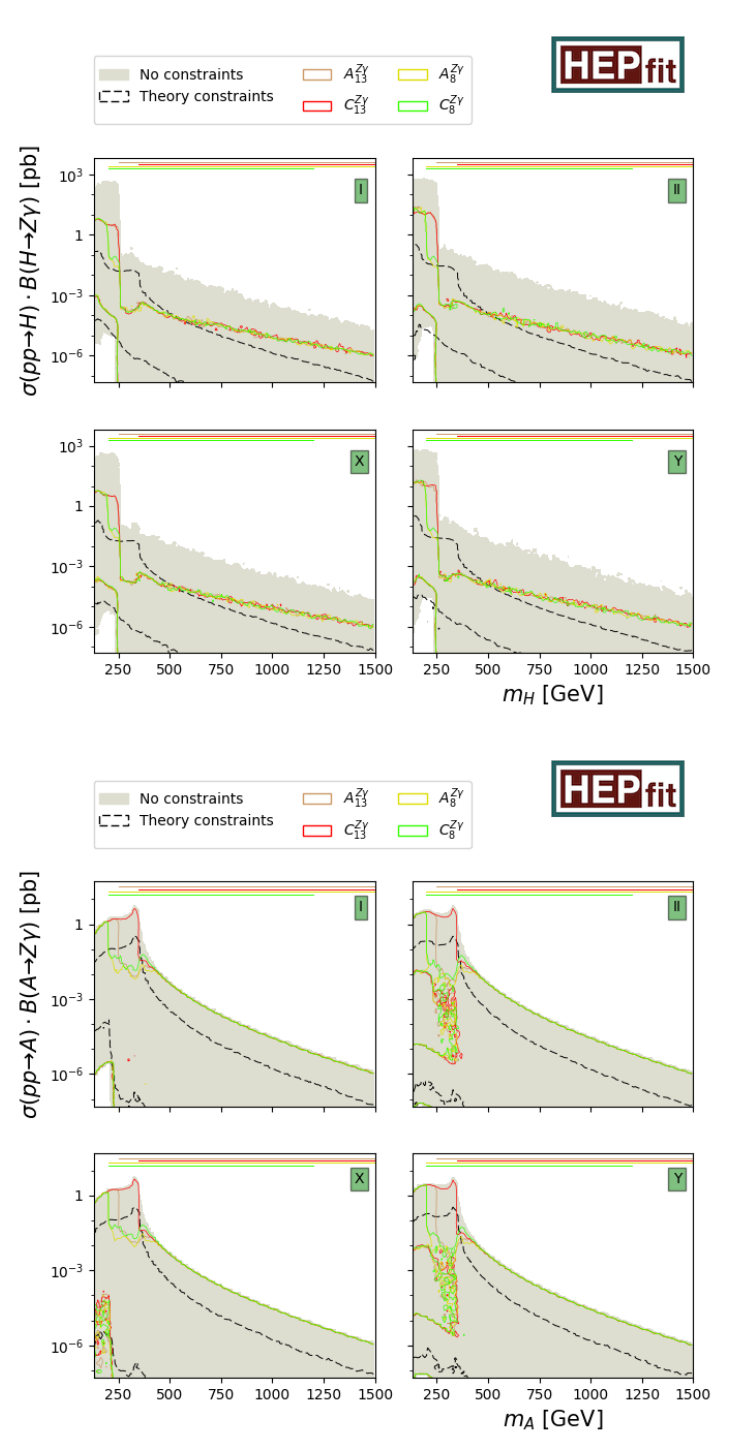
Figure 9 . 95% contours of the single searches for H=A ! Z(cid:13) in the (cid:27) (cid:1) B vs. m four 2HDM types (top: H , bottom: A ). For details, see text.